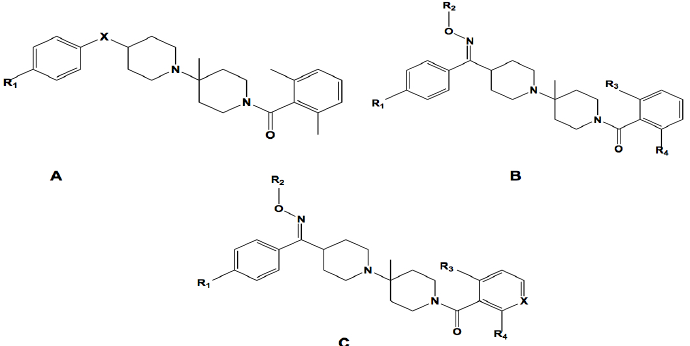
Figure 3. The 2D structures for the oxamino-piperidino-piperidine amide analogs used in the 3D QSAR of this work.